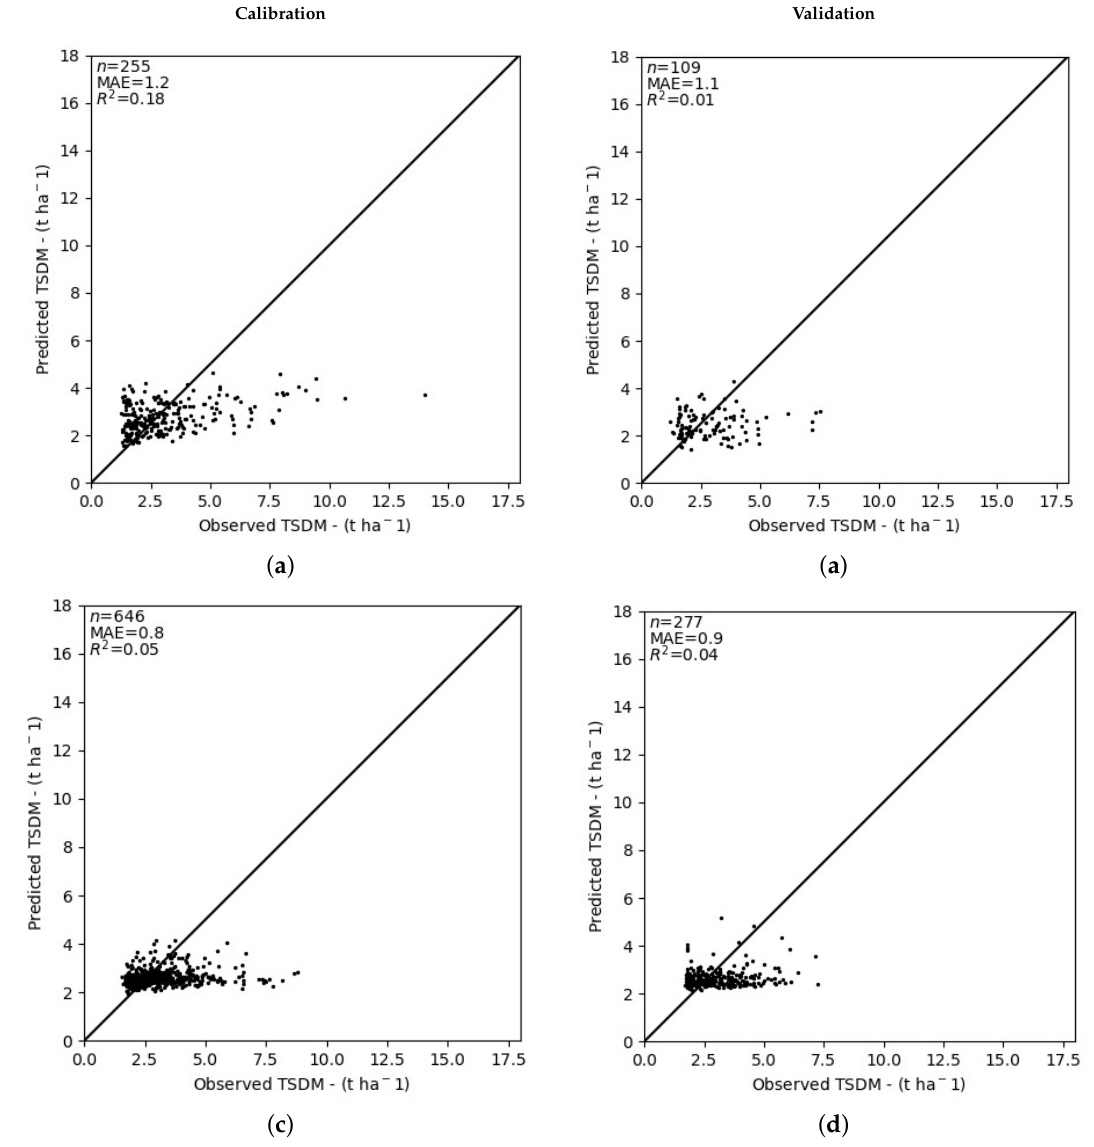
Figure 12. Least squares linear relationship between RPAS-estimated biomass and Planet Dove satellite image data-predicted biomass at peak growth for both the tall grassland ( a , b ) and tall woodland ( c , d ) pasture models.